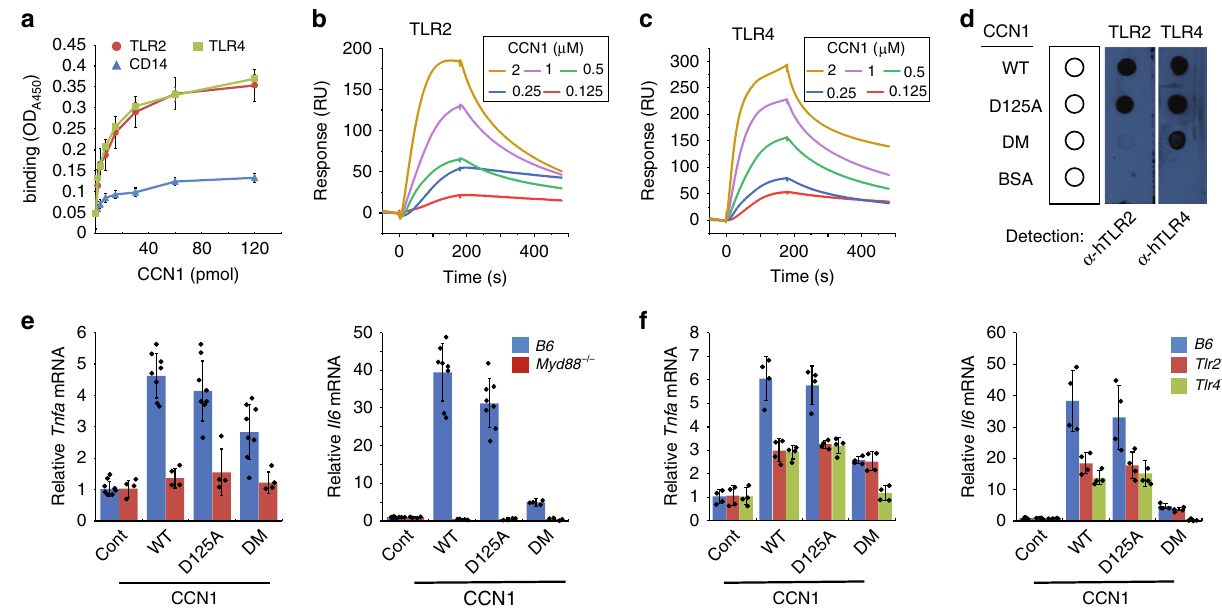
Fig. 8 CCN1 binds and activates TLR2 and TLR4. a Solid-phase-binding assays between CCN1 and TLR2/4. Recombinant TLR2 or TLR4 proteins (200 ng per well) were added to 96-well plates pre-coated with serially diluted CCN1 protein at indicated amounts. Speci fi c interaction was detected and quanti fi ed using polyclonal anti-hTLR2 or anti-hTLR4 antibodies. Recombinant CD14 (200 ng per well) was used as a control. b SPR analyses of CCN1 binding to TLR2. TLR2 was immobilized on CM5 chip and various concentrations of CCN1 was injected as analyte. c Sensorgrams of CCN1 binding to TLR4 analyzed by SPR as in b . d Dot blot analyses of CCN1 and mutant proteins binding to TLR2/4. CCN1-WT, CCN1-D125A, or CCN1-DM proteins (1 µ g each) were spotted onto nitrocellulose membrane and incubated with TLR2 or TLR4 proteins (2 µ g each in PBS) for 4 h. Binding was detected using polyclonal anti- hTLR2 or anti-hTLR4 antibodies. A representative image is shown. e Tnfa and Il6 mRNAs were quanti fi ed in BMDMs from either B6 or MyD88 − / − mice treated with CCN1-WT, CCN1-D125A, and CCN1-DM mutant proteins using qRT-PCR analysis. f Tnfa and Il6 mRNAs from BMDMs of B6 , Tlr2 − / − , or Tlr4 − / − mice treated with CCN1 proteins (CCN1-WT, -D125A, -DM, 2 μ g per ml each) were quanti fi ed using qRT-PCR analyses. All data are represented as mean ± s.d. acquired in triplicate determinations. Statistical evaluation was performed by one-sided, two-sample with equal variance t -tests. * p < 0.05, ** p < 0.01, and n.s. = not signi fi cant. Source data are provided as a Source Data fi le.